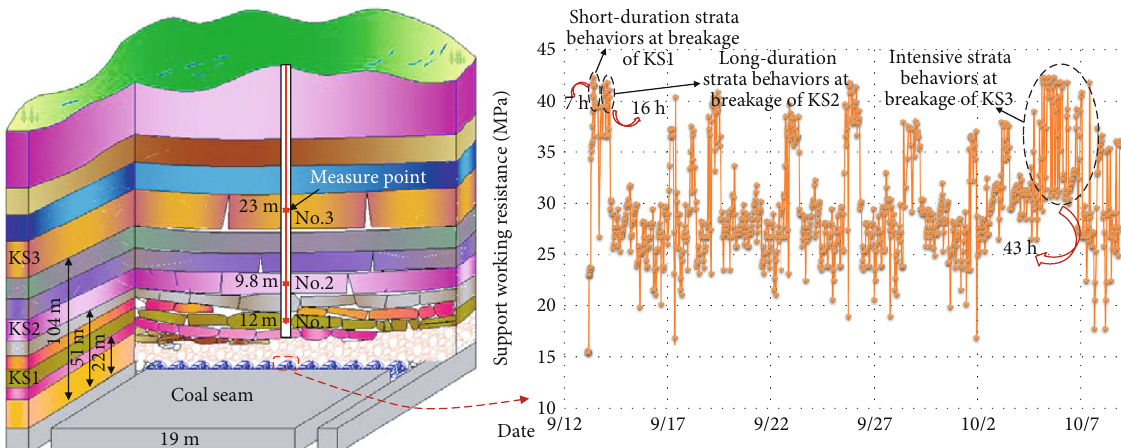
Figure 8: Ground pressure during the breaking of strata at di ff erent